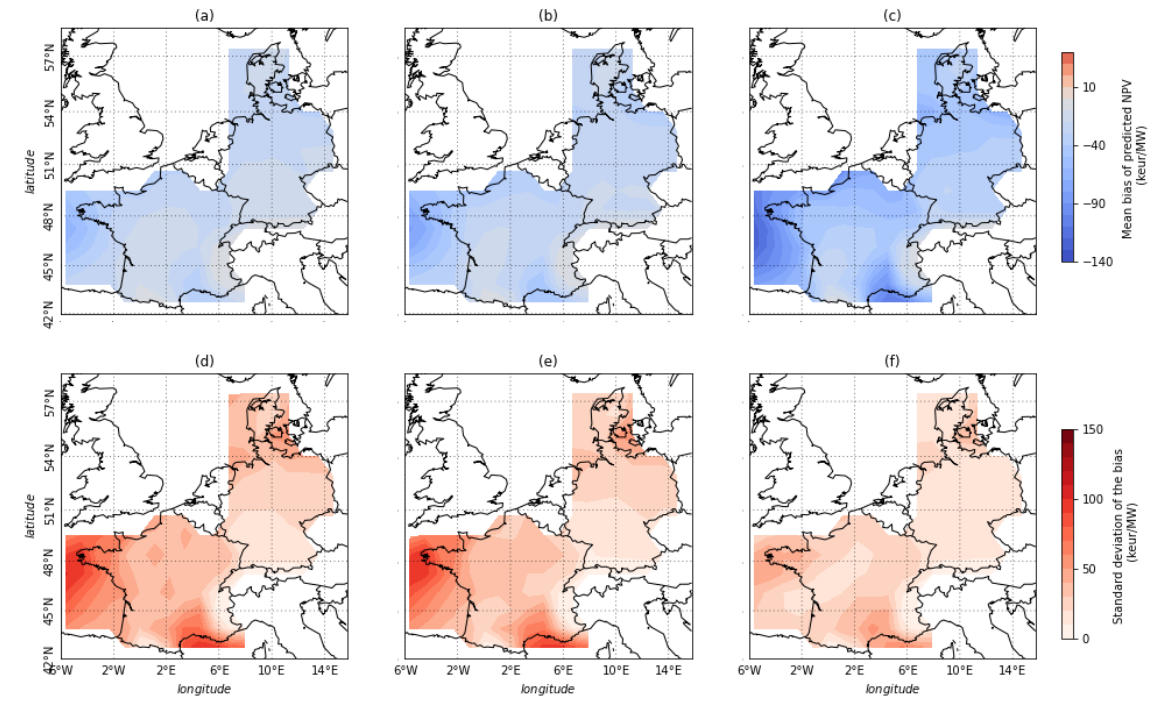
Figure 8. Mean ( a – c ) and standard deviation ( d – f ) of the bias calculated between the NPV at the end of a project and the projected NPV based on ( a , d ) the past 5 years, ( b , e ) the past 10 years, and ( c , f ) the past 30